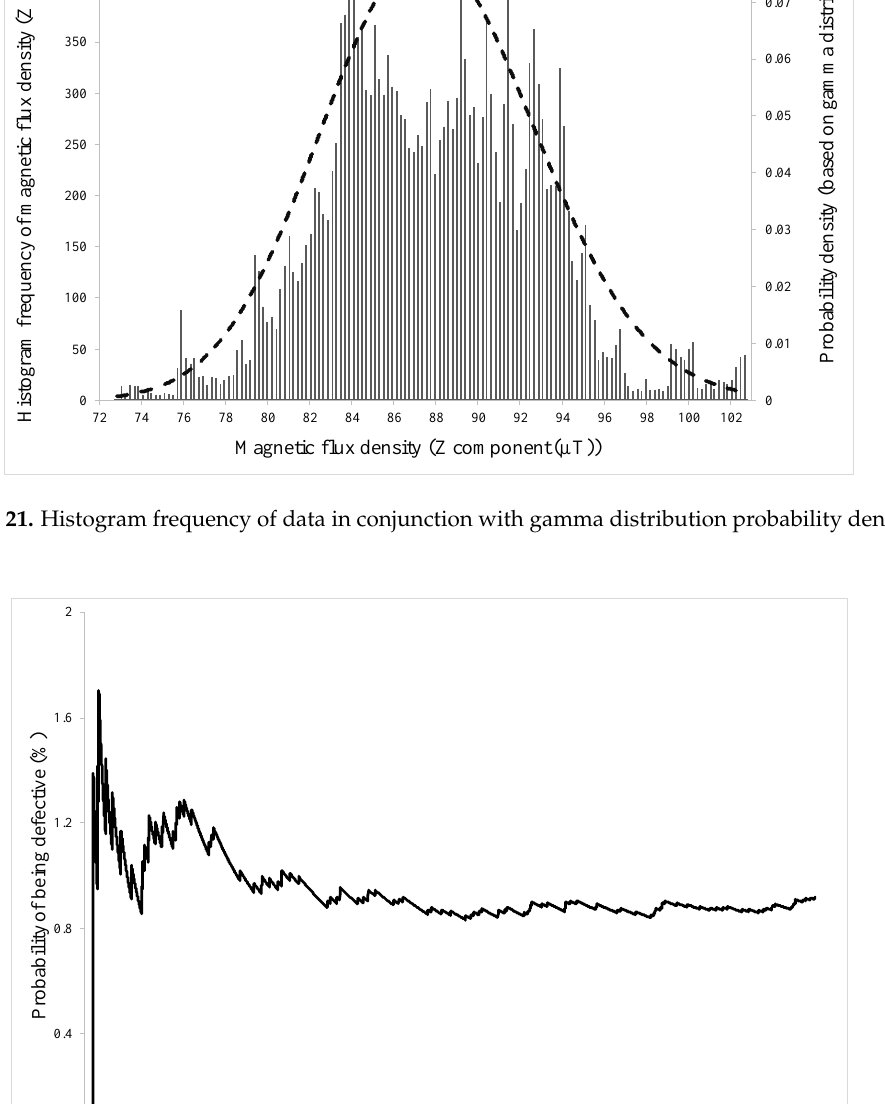
Figure 21. Histogram frequency of data in conjunction with gamma distribution probability density.